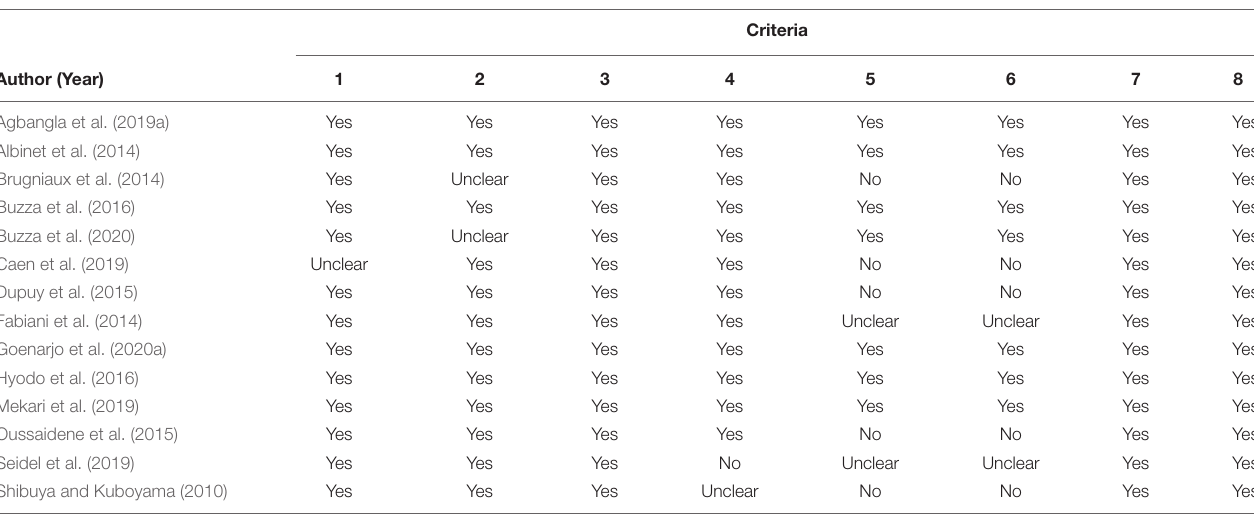
TABLE 3 | JBI quality